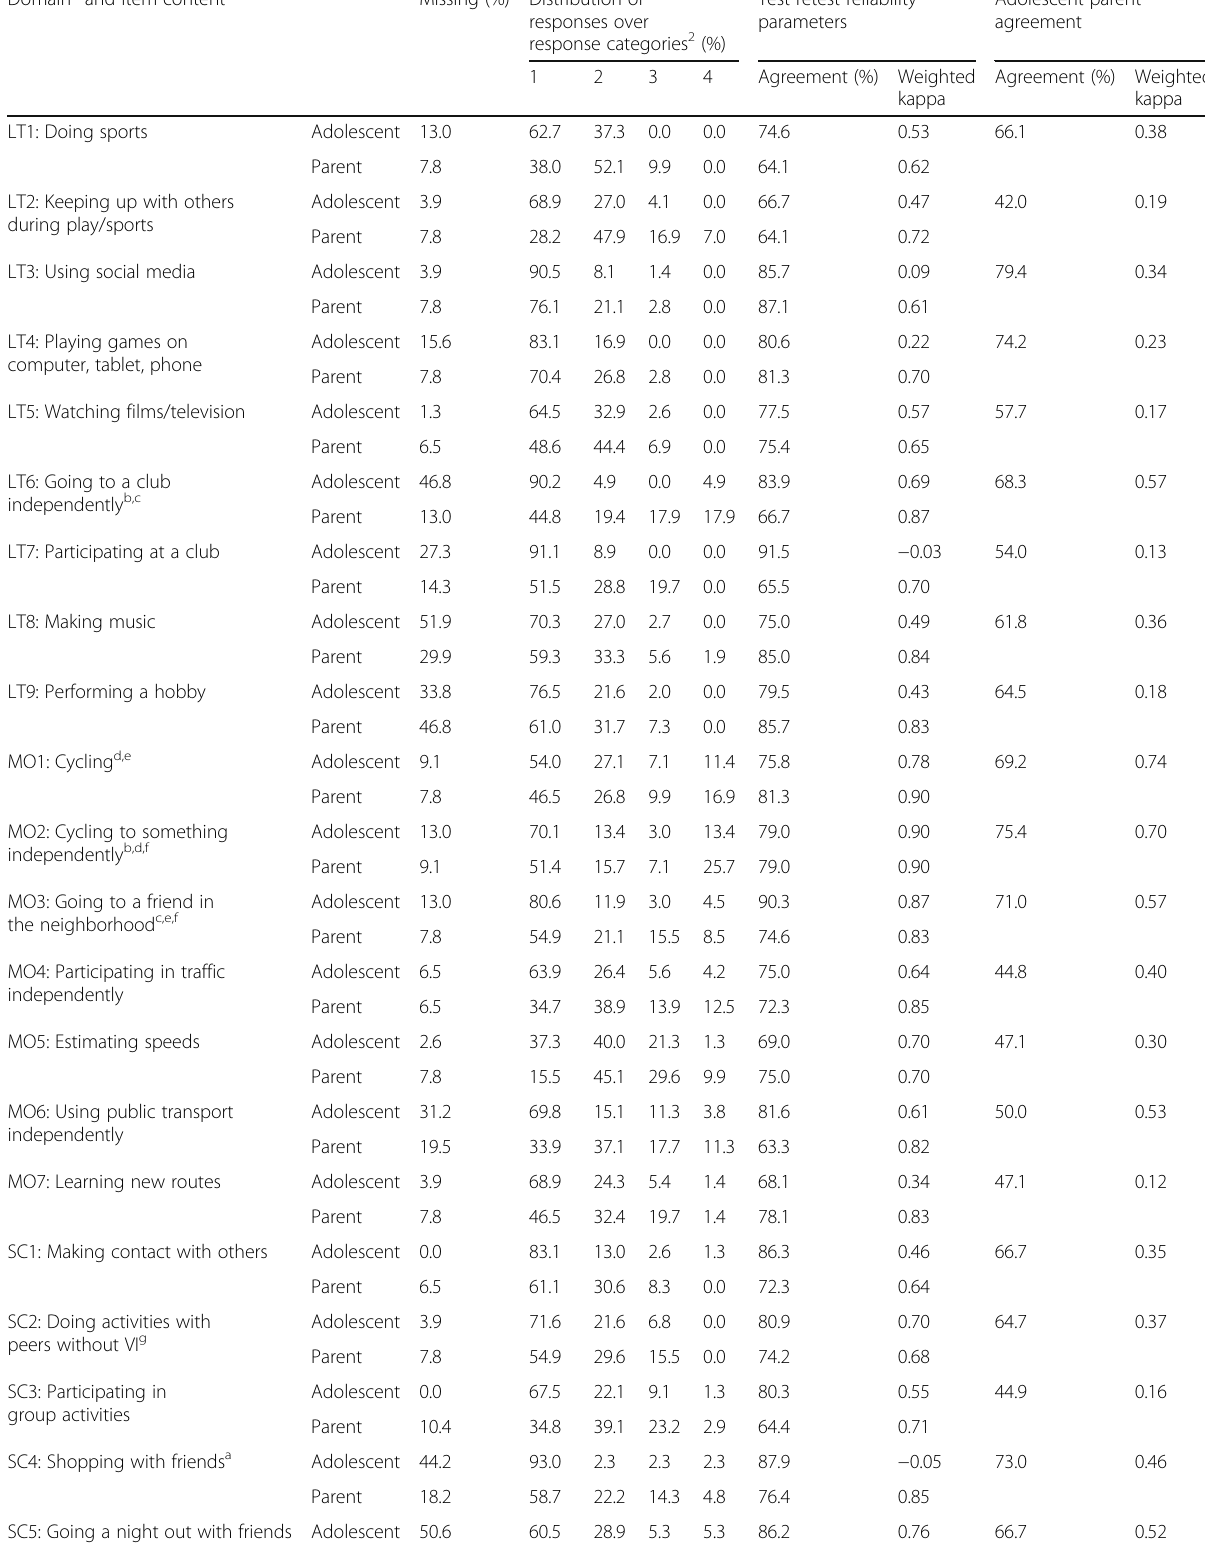
Table 2 Distribution of responses and parameters of test-retest reliability and adolescent-parent agreement Domain 1 and item